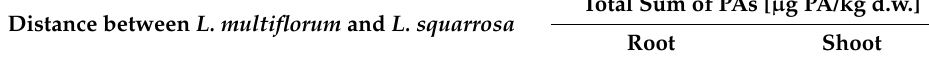
Table 2. Effect of distance on the PA-content of L. multiflorum (Plot G, Figure 1) growing next to a plot of L. squarrosa (Plot A, Figure 1). Total Sum of PAs [ µ g PA/kg d.w.] Distance between L. multiflorum and L. squarrosa Root Shoot 50 cm without vessel 19.2 335.1 50 cm with vessel